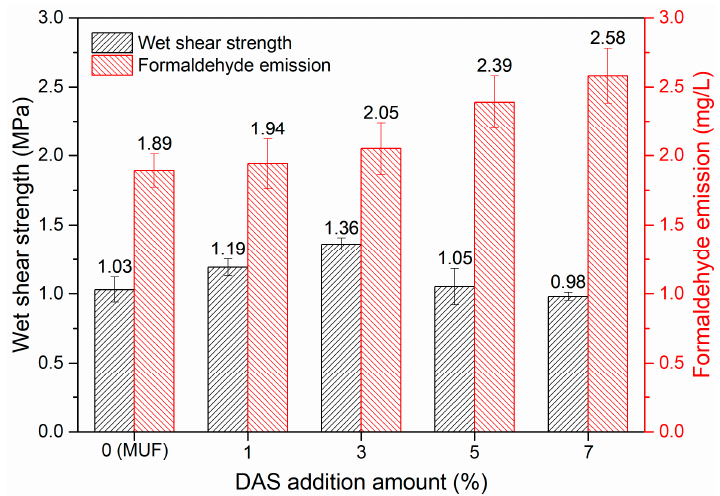
Figure 11. Wet shear strength of the plywood bonded by MUF resin and DAS-modified MUF resins with di ff erent DAS levels.